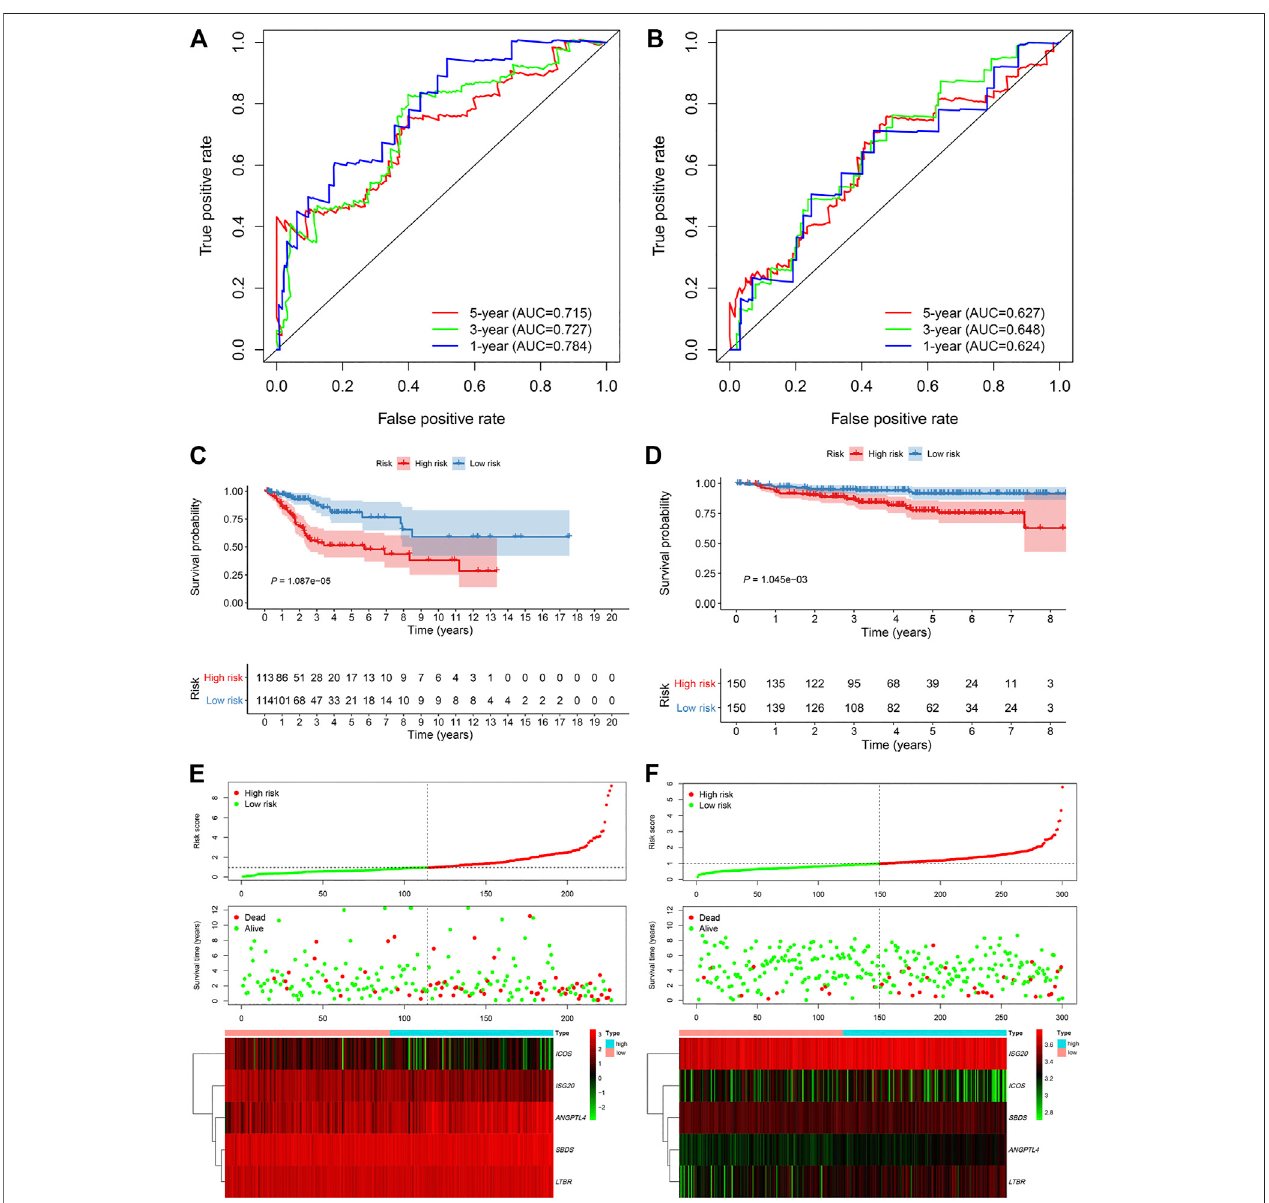
FIGURE2| The5-immune-gene signatureshowedgood performancein TCGA andGEOcohort. Time-dependentROCanalysisin (A) TCGA cohortand (B) GEO cohort. Kaplan – Meier survival analysis in (C) TCGA and (D) GEO cohort. Signature risk score analysis in (E) TCGA and (F) GEO cohort. TCGA, The Cancer Genome Atlas; GEO, Gene Expression Omnibus; ROC, receiver-operating